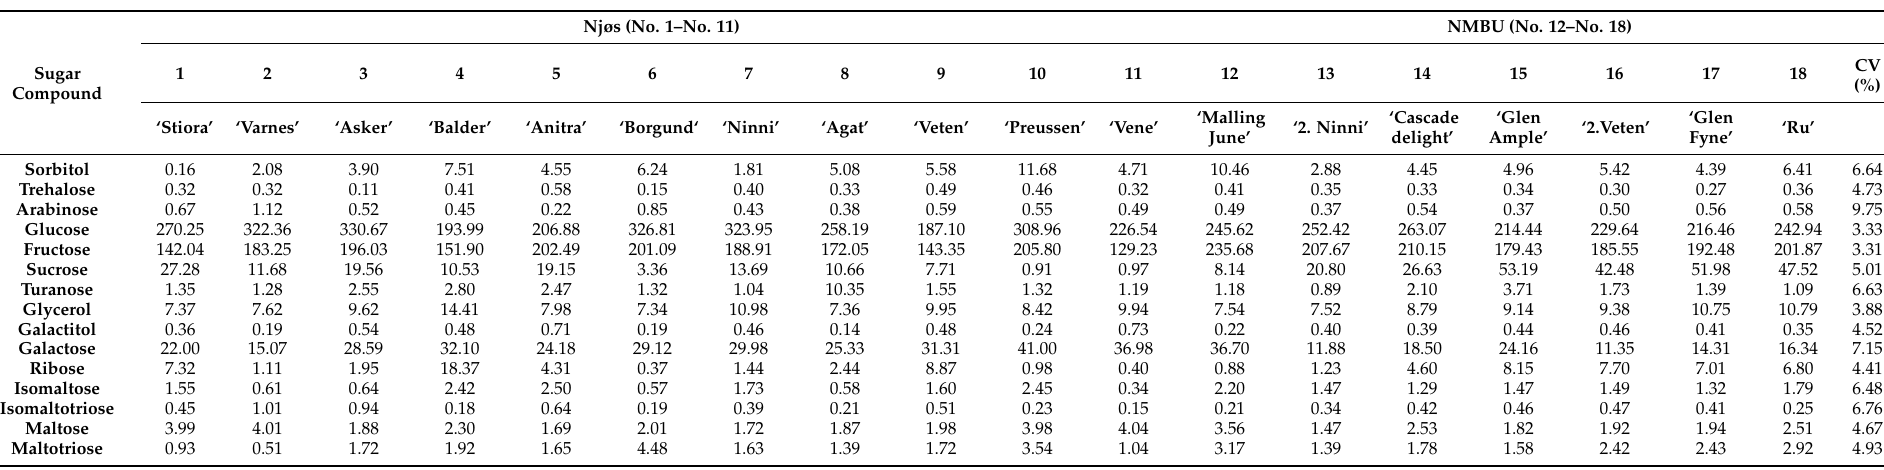
Table 3. The averages of the values of sugar contents (g/kg) in 18 raspberry extract samples during the two-year collection from two Norwegian regions (Njøs